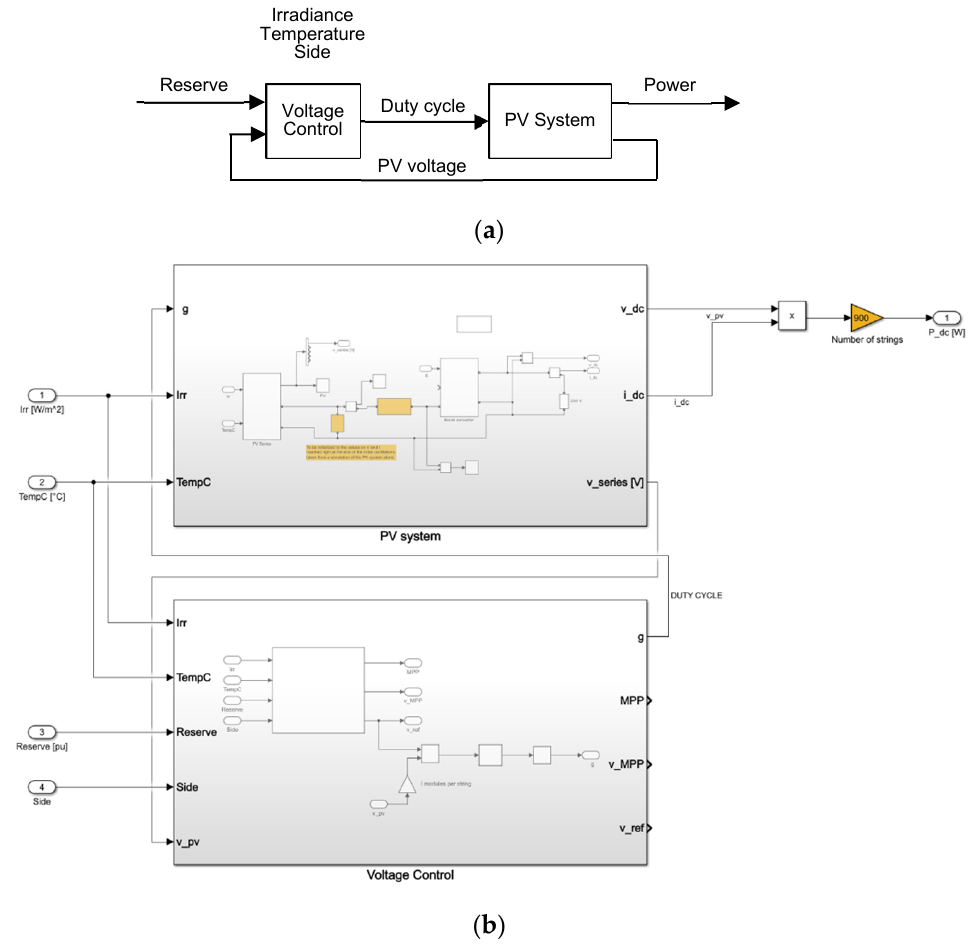
Figure 5. Photovoltaic system model: ( a ) General flowchart showing the electrical model (left block) and the voltage control (right block); ( b ) Simulink implementation, including the electrical model (upper subsystem) and the voltage control (bottom subsystem).